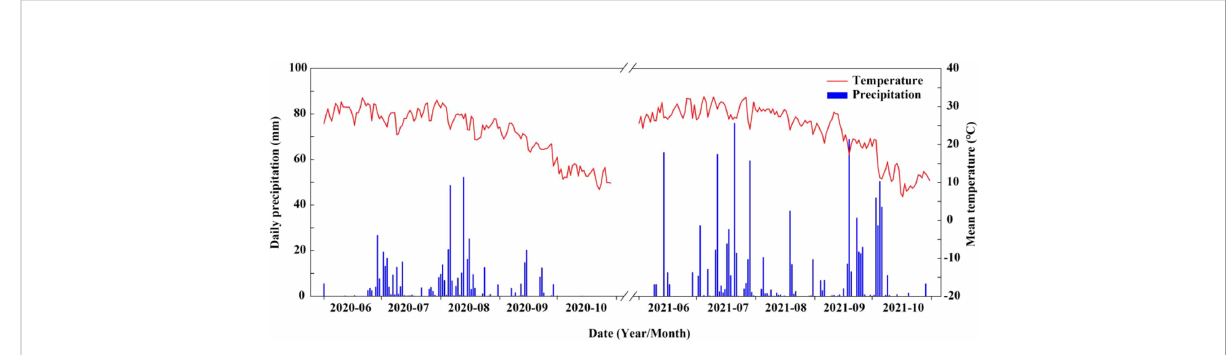
FIGURE 1 Mean temperature and daily precipitation during maize growing seasons at the experimental site in 2020 and